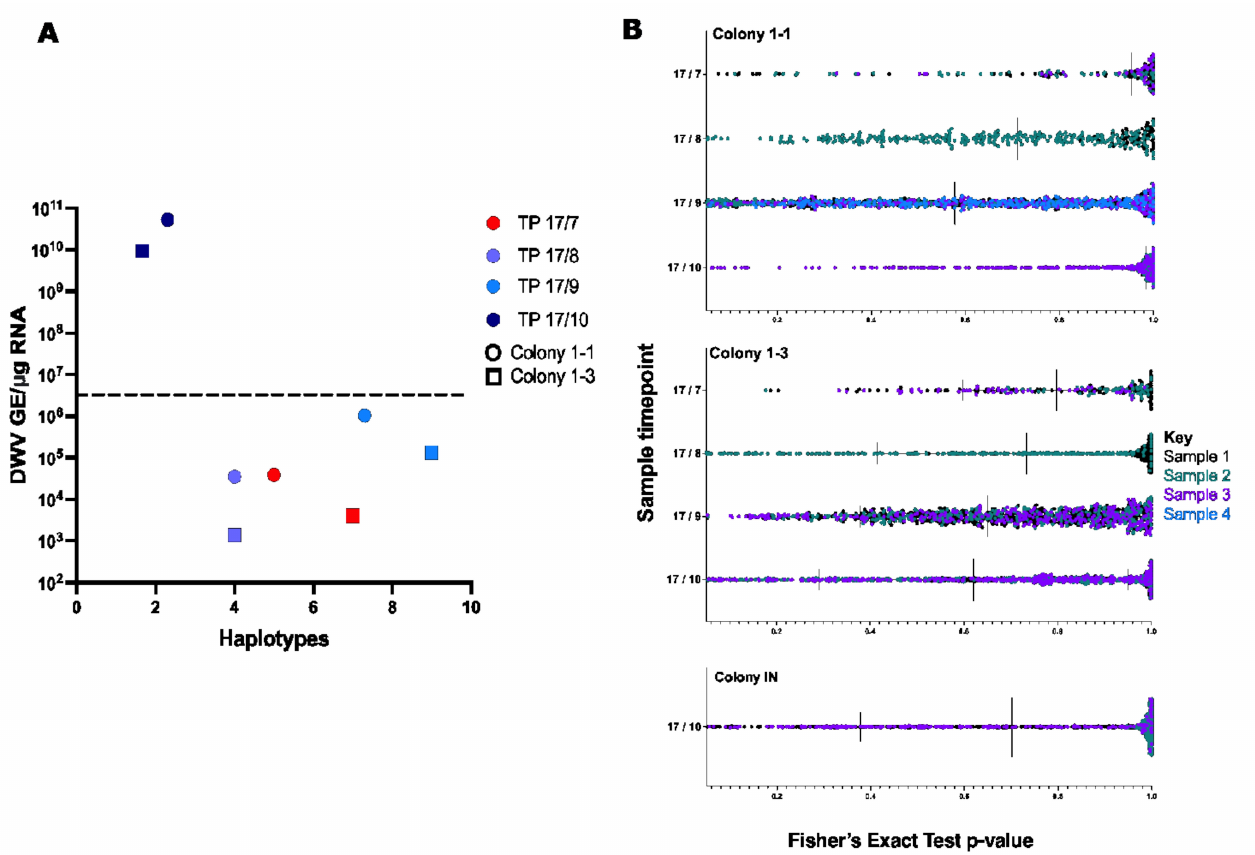
Figure 4. Deformed Wing Virus sequence diversity changes in two Varroa-naïve colonies. ( A ). The average DWV load from each time point and the number of haplotypes shared amongst the samples sequenced in Colony 1-1 and Colony 1-3 are compared. Samples are coloured by timepoint and shaped by colony. Dashed line indicates known threshold for symptomatic infections in developing bees [7]. ( B ). SNVs from ShoRAH analysis for all samples from colonies 1-1, 1-3 and IN were called if present in 3 iterations of the modelling, as described in Figure 2B. The different colours at each time point represent the SNVs for each honeybee sample sequenced and match the corresponding colours to the left of Figure S3. Vertical black lines show the median (larger lines) and interquartile range for the p -value